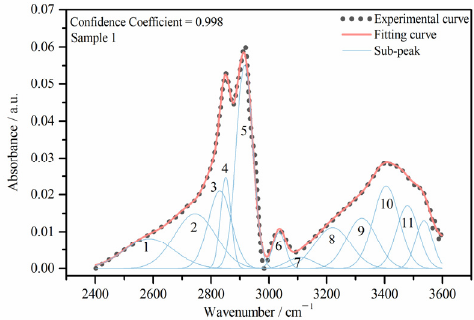
Figure 3. Deformation characteristics of the ductile deformed coals. ( a ) Sample 2, ( b ) Sample 3, ( c ) Sample 4, ( d ) Sample 5, ( e ) Sample 6, ( f ) Sample 7, ( h ) Sample 8, ( i ) Sample 9.